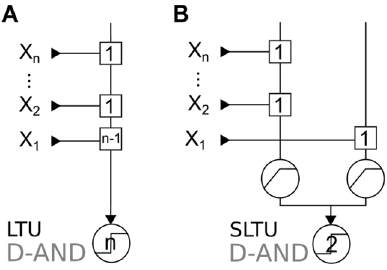
Figure 3. Extending the D-AND implementation to n inputs. Synaptic weights are in squares, and transfer functions are in circles. A : Minimal D-AND implementation in an LTU. Note that this implementation requires a synaptic weight that is n − 1 times bigger than the smallest weight. B : Implementation in an SLTU with sub-linear summation (see Definition 5).